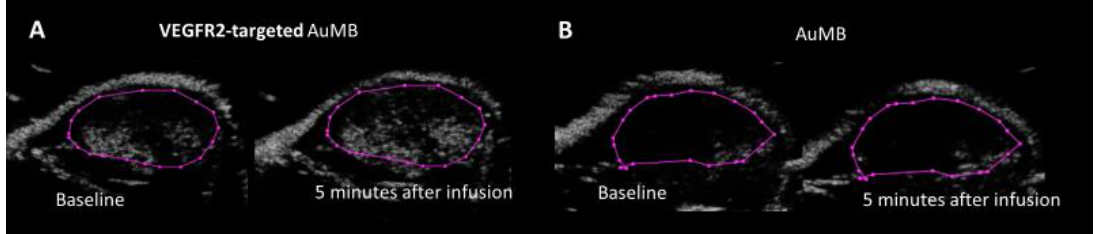
Figure 8. Representative harmonic B-mode ultrasonic images (20-MHz transducer) of xenograft tumors with VEGFR2-targeted AuMBs ( A ) or AuMBs ( B ) infused at baseline and 5 min later. The dynamic range was 50 dB with gain of −26 dB. The average enhancement in the pixel intensity was 7.84 vs. 0.27 a.u. ( p < 0.05).